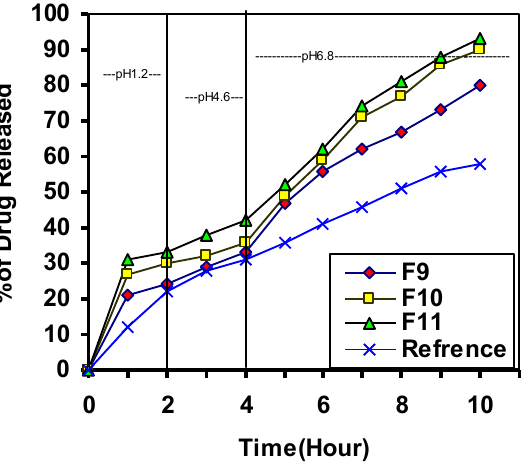
Figure 4. Effect of PVP addition on the cumulative released of PTX from tableted matrix at different pH-medium